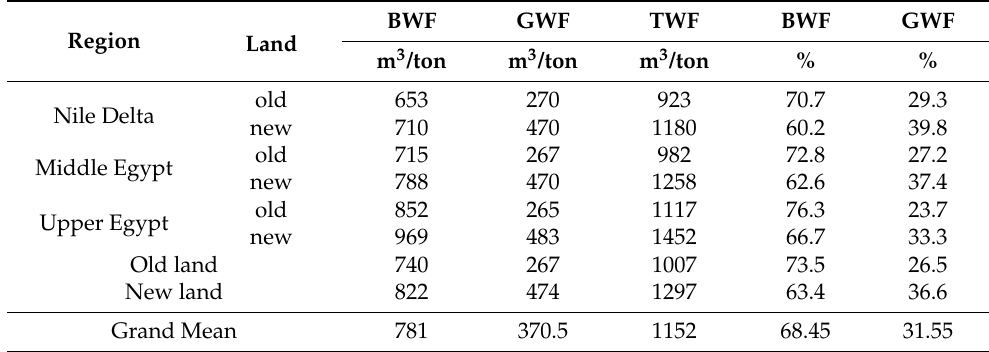
Table 7. Mean blue and grey water footprints and total water footprint for wheat for three climate regions and two soil types, i.e., old and new land.